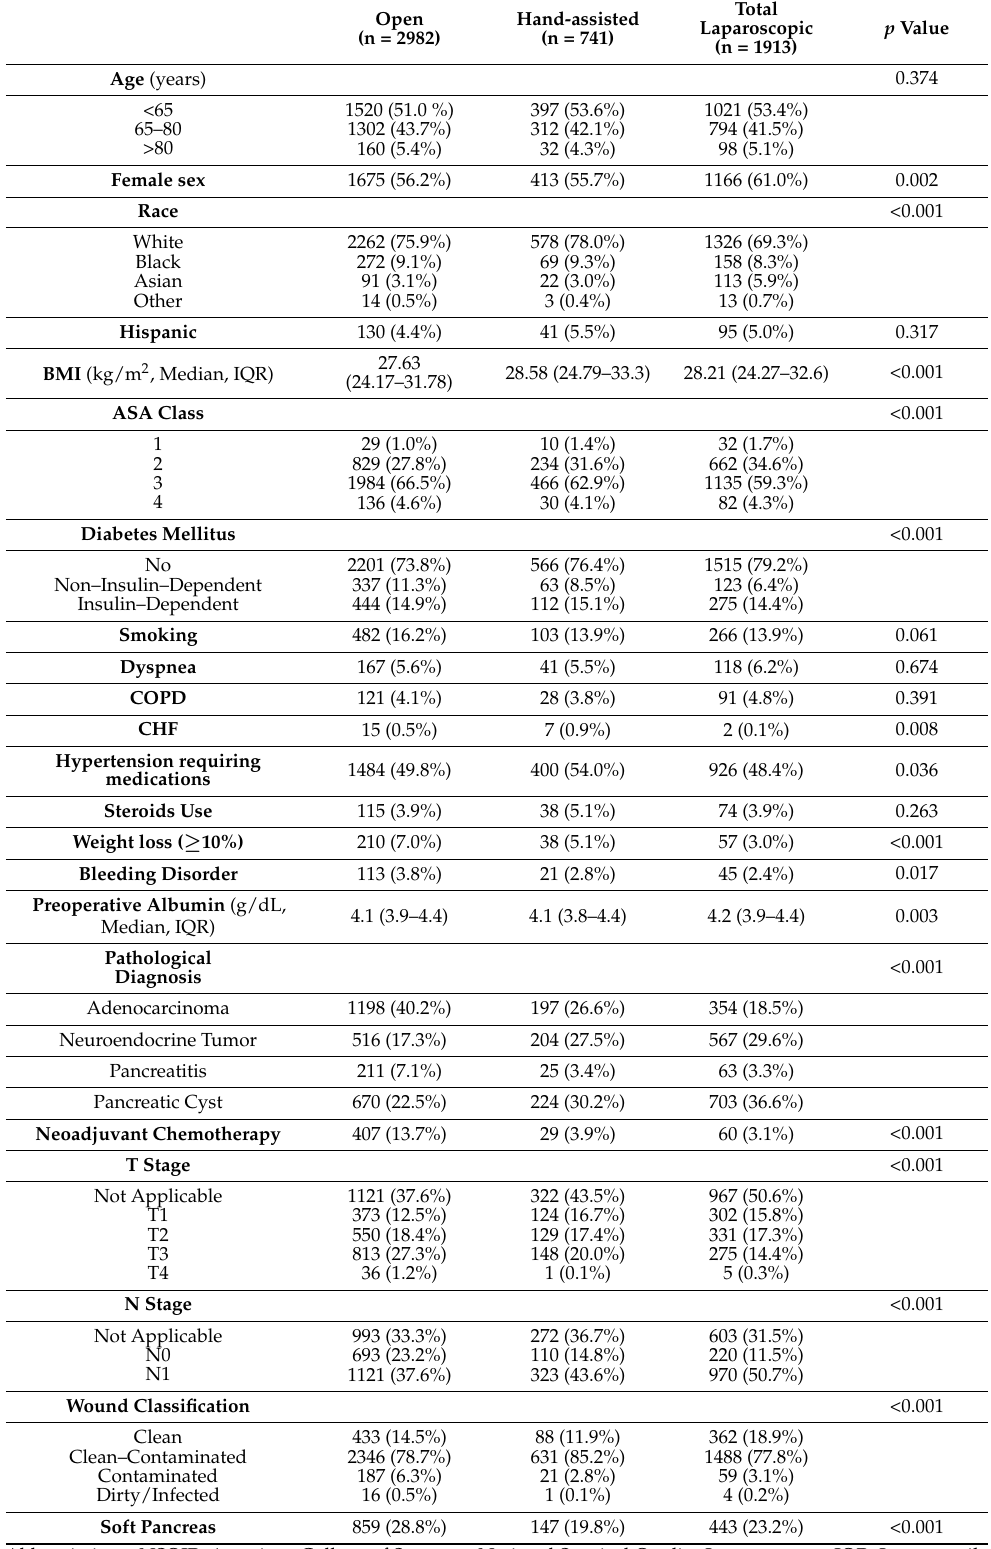
Table 1. Demographic and Preoperative Clinical Characteristics of Patients Undergoing Distal Pancreatectomy in NSQIP